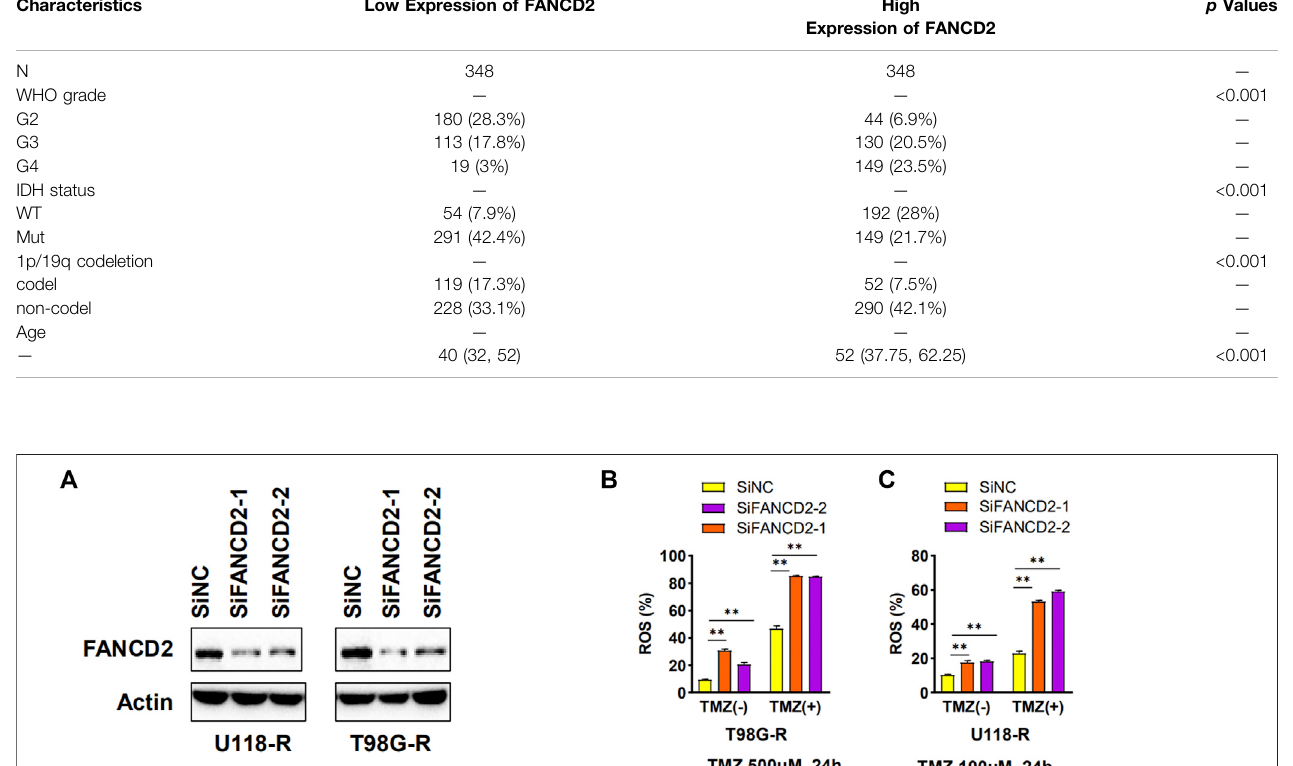
TABLE 2 | Association between the patients ’ clinical characteristics and FANCD2 expression levels in GBM patients. Characteristics